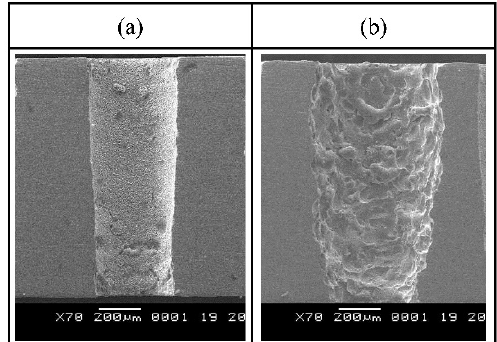
Figure 5. SEM image of micro hole profile under different pulse on time; ( a ) 5 µs, ( b ) 25 µs.